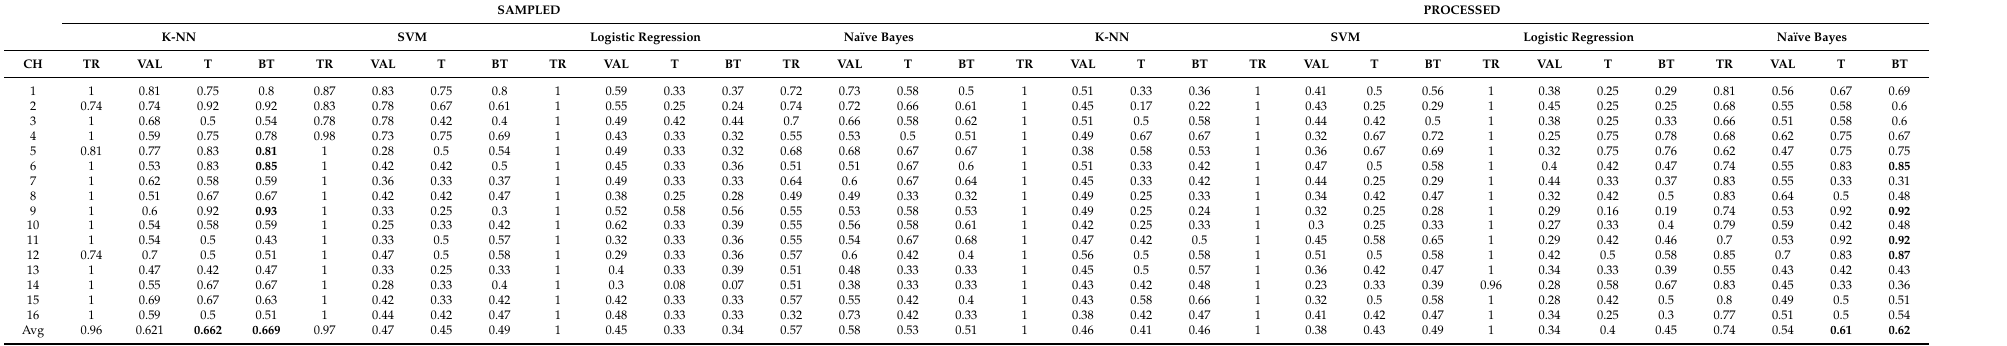
Table 2. Accuracy results of channel